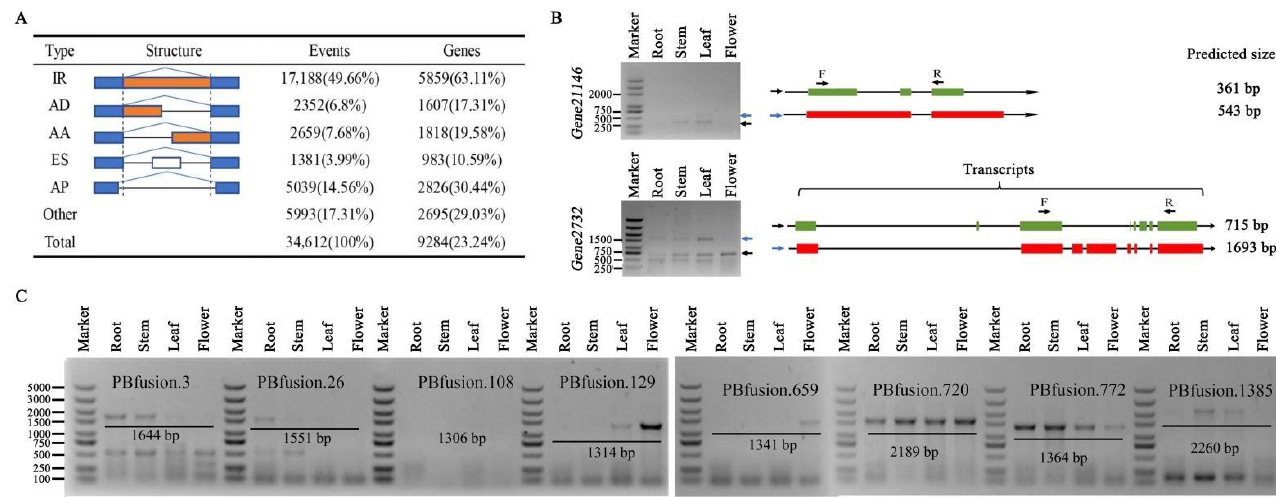
Figure 2. Characterization of AS events and validation of AS events and fusion transcripts using RT-PCR. ( A ) Classification of AS events. ( B ) RT-PCR validation of AS events in two genes. The transcripts structure of each isoform, from the Tp_v2.0 genome and PacBio dataset, are shown in green and red in the right panel, respectively. Green and red boxes show exons and lines with arrows show introns. PCR primers (F, forward and R, reverse) are shown on the first isoform of each gene. The length of each full-length isoform is shown behind the transcript structure. ( C ) RT-PCR validation of fusion transcripts.